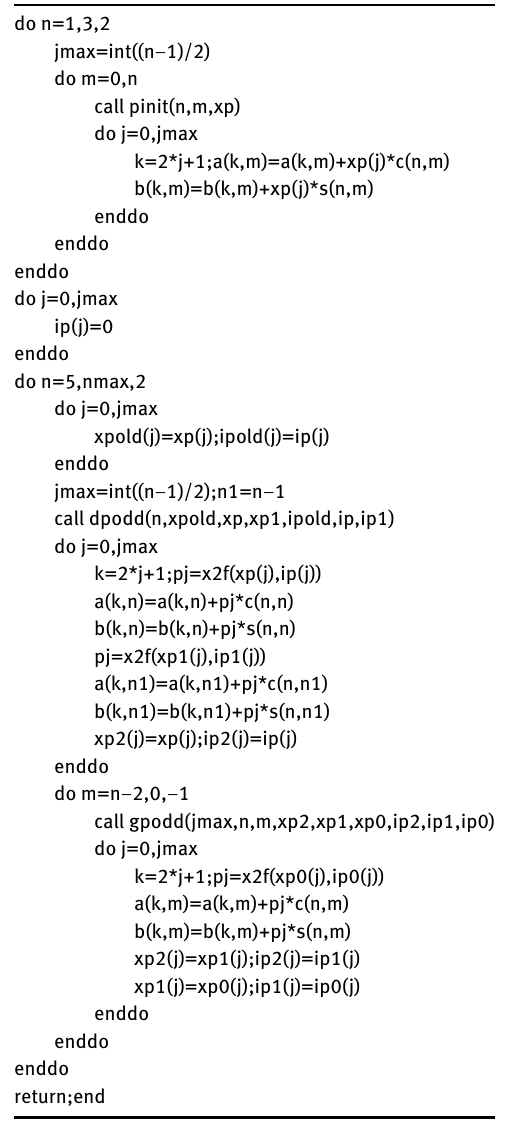
(cid:17) to ( A km , B km )